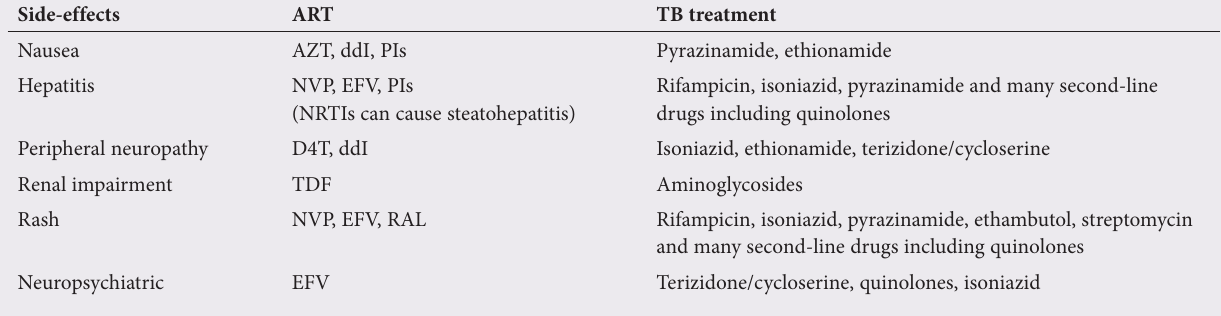
Table 7. Shared side-effects of TB treatment and ART Side-effects